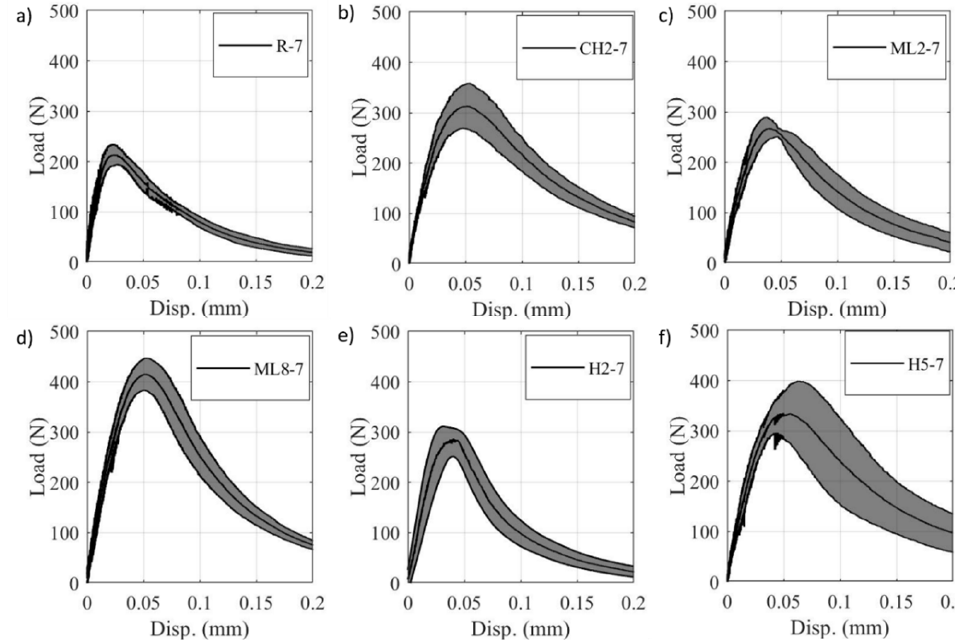
Figure 10. Comparison of notched bending response for the mean and variance ( a ) reference and carbon fiber reinforced cementitious composite mixes (( b ) CH2, ( c ) ML2, ( d ) ML8, ( e ) H2, and ( f ) H5) at seven days of age. Each graph represents the mean of five tested samples.